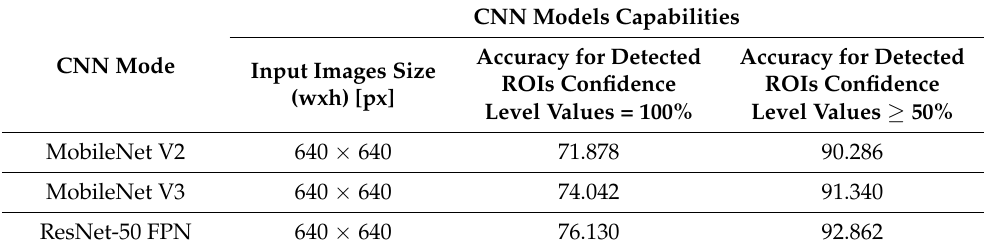
Table 1. Pre-trained CNN models that were used by the proposed faster R-CNN algorithm training